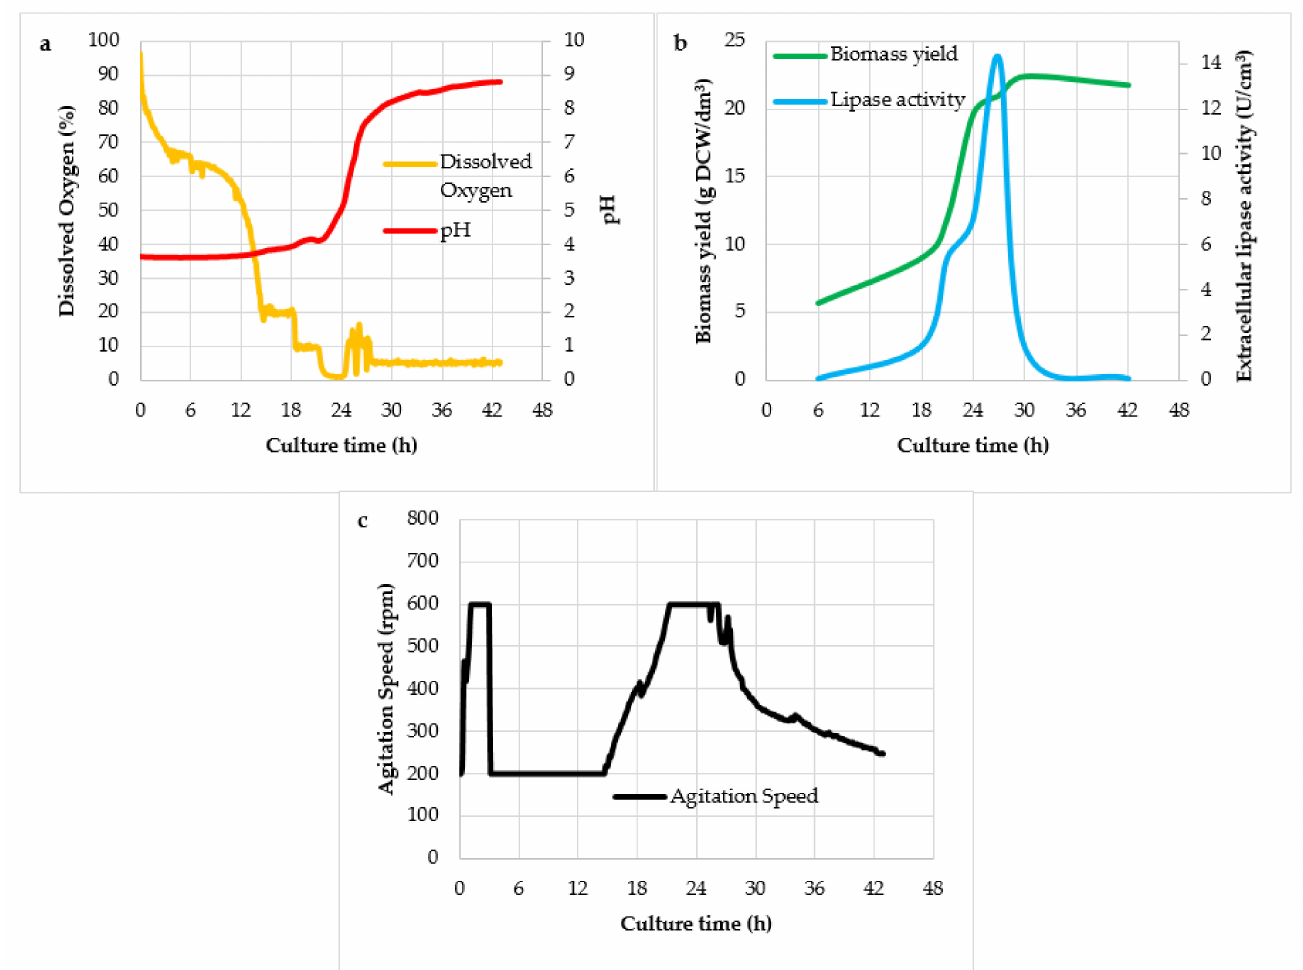
Figure 5. Kinetics of dissolved oxygen and pH ( a ), biomass yield and extracellular lipase activity ( b ), and agitation speed ( c ) of the yeast strain Y. lipolytica KKP 379 in the culture with a variable agitator speed dependent on the medium aeration and air flow of 1.75 dm 3 /(dm 3 ×